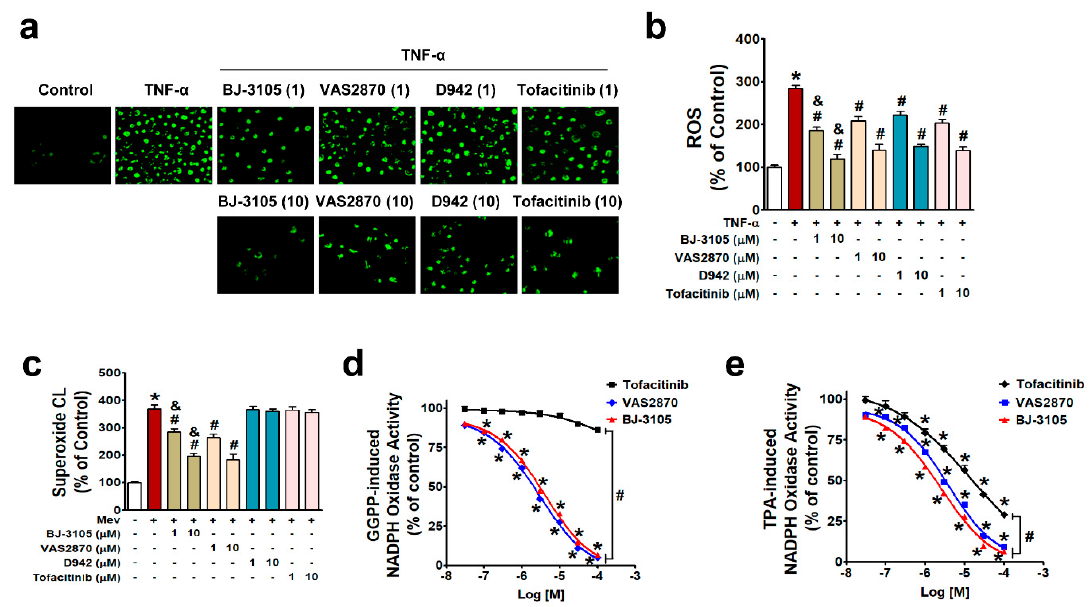
Figure 5. Inhibitory effects of BJ-3105, tofacitinib, D-942, and VAS2870 on TNF- α -, mevalonate, GGPP-, or TPA-induced ROS and NOX activities in HT-29 cells. ( a,b ) TNF- α -induced ROS levels in serum-starved HT-29 cells were measured by detecting DCF fluorescence using fluorescent microscopy ( a ) and microfluorometry ( b ). ( c ) Superoxide radical production was measured using a lucigenin chemiluminescence assay. ( d , e ) NOX activity was measured using lucigenin in cell extracts and GGPP ( d ) or TPA ( e ) as a stimulator. Results are presented as the means ± SEMs of three independent experiments. * p < 0.05, versus vehicle-treated controls. # p < 0.05, versus stimulator (TNF- α , mevalonate, GGPP, or TPA)-treated cells. & p < 0.05, versus tofacitinib- or VAS2870-treated cells.